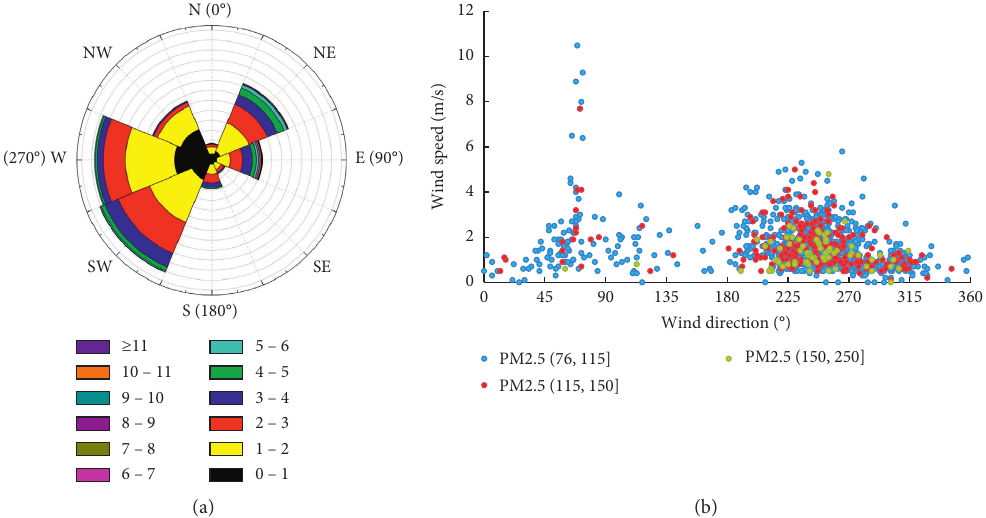
Figure 13: The wind rose diagram at Qinhuangdao. (a) The relationship between PM2.5, (b) mass concentration, and wind speed and wind direction in